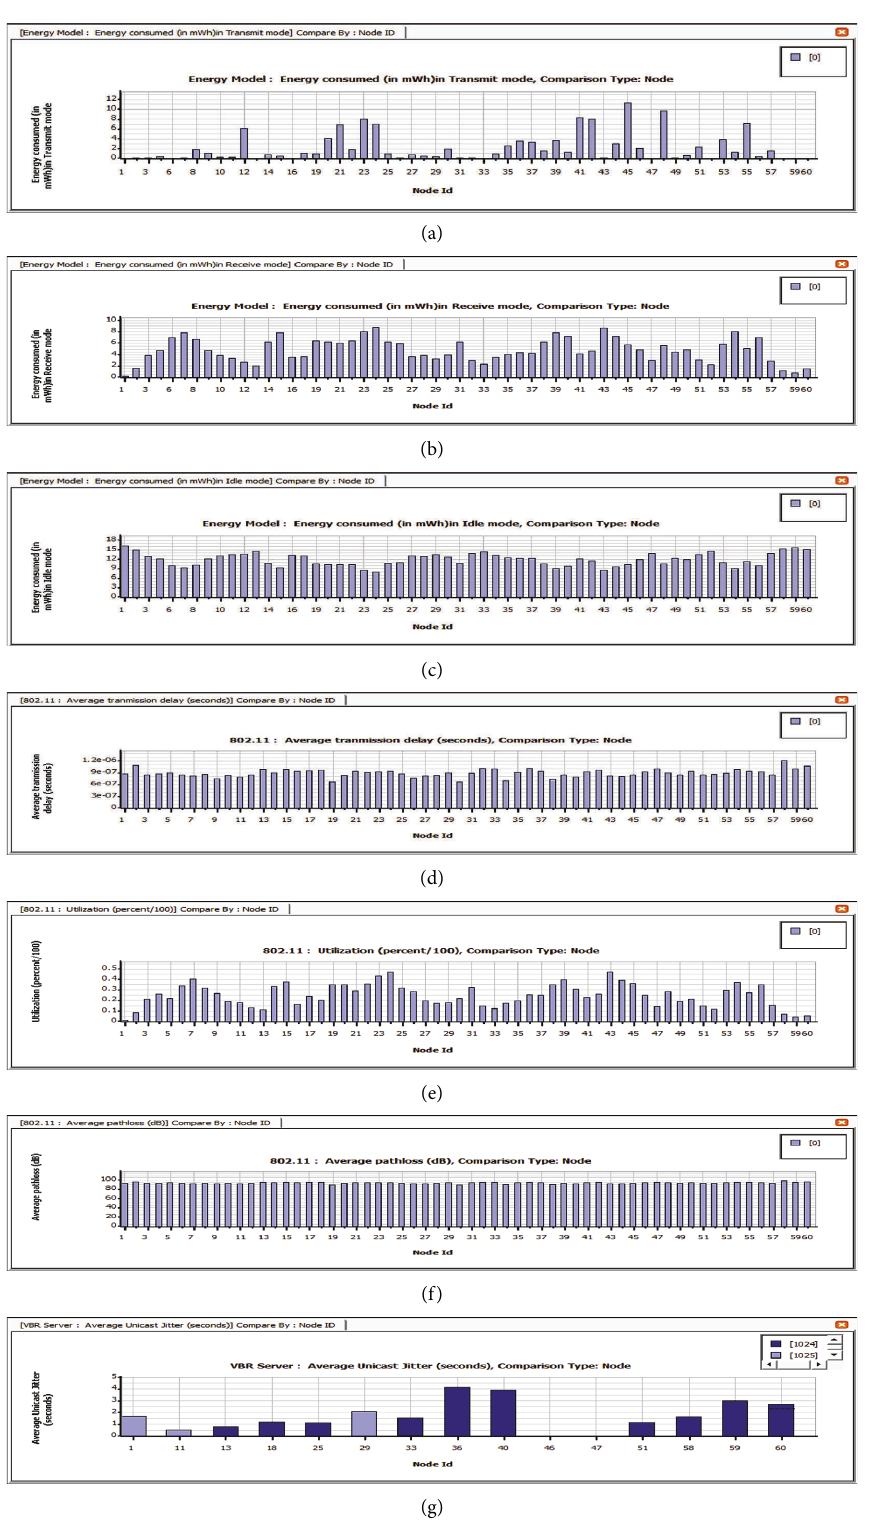
Figure 24: (a) Transmit mode energy consumption of BELLMAN FORD for VBR deployment. (b) Receive mode energy consumption of BELLMAN FORD for VBR deployment. (c) Idle mode energy consumption of BELLMAN FORD for VBR deployment. (d) Average transmission delay of BELLMAN FORD for VBR deployment. (e) Percentage of utilization of BELLMAN FORD for VBR deployment. (f) Average pathloss of BELLMAN FORD for VBR deployment. (g) Average jitter of BELLMAN FORD for VBR